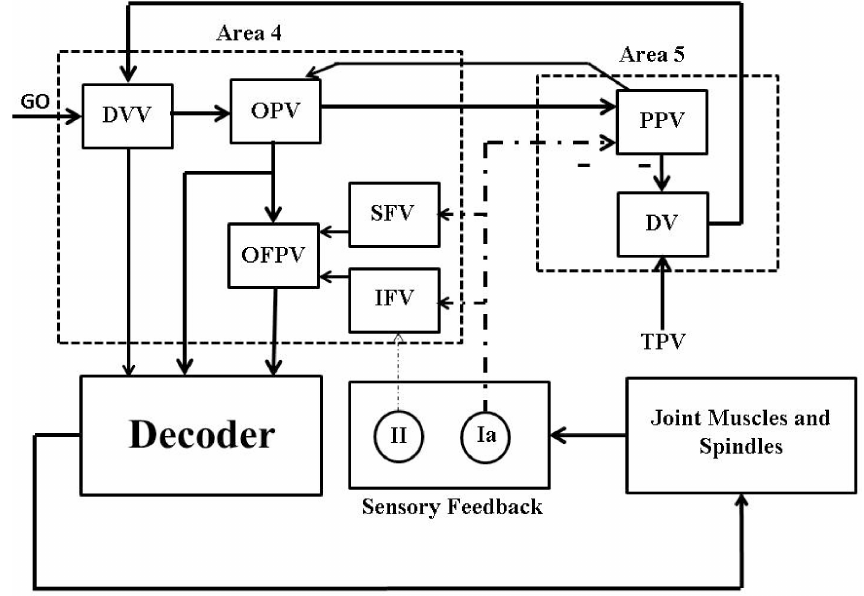
Figure 6. A closed-loop BMI system design using the natural proprioceptive feedback information (sensory